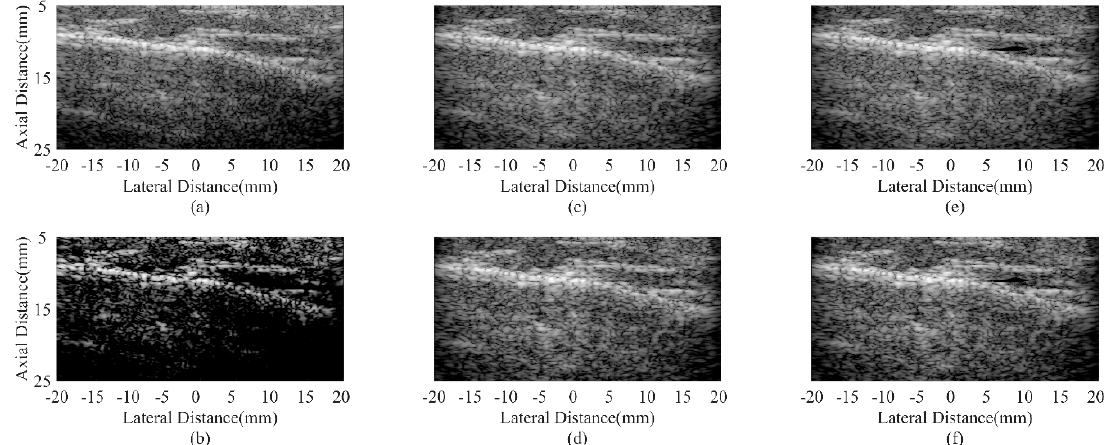
Figure 11. In vivo human parotid images using different beamformers: ( a ) DAS, ( b ) CF, ( c ) JTR-MV, ( d ) JTR-MV GCF, ( e ) JTR-ESBMV, ( f ) JTR-ESBMV GCF. All images are shown with a dynamic range of 60 dB.